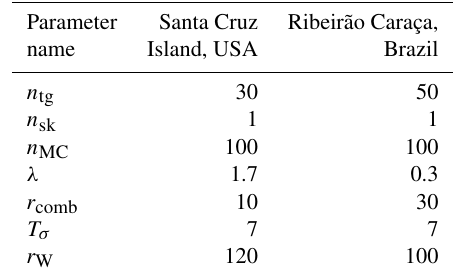
Table 1. Parameter values used for the two field sites. Differences in parameter values between the two sites are due to differing DEM resolution (1m for Santa Cruz Island and 12m for the Ribeirão Caraça). Sensitivity to these parameters is described in Sect. 4.3. Note that although the parameter values have been carefully opti- mised for knickpoint analysis, we suggest the values below as de- faults for each of these two data resolutions in order to allow for a rapid initial knickpoint extraction for other landscapes.